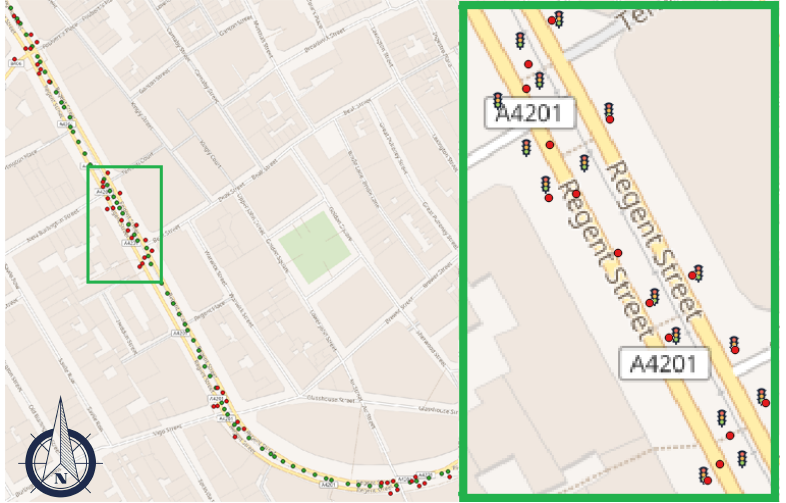
Figure 3. Map of traffic lights automatically detected in Regent Street, London, UK. Green dots, red dots, and traffic light symbols (in zoom) are the GSV camera locations, geotagging results, and the actual locations of objects, respectively.